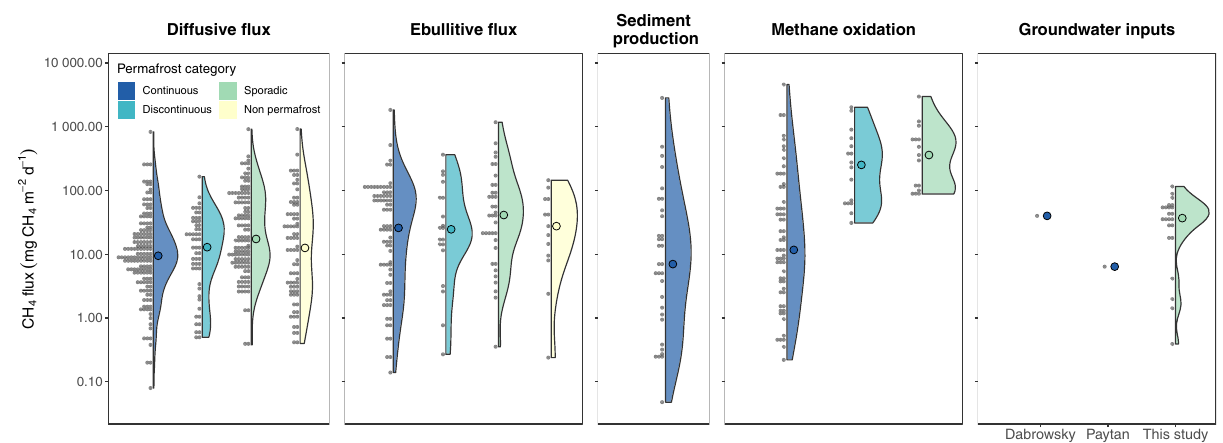
Fig. 4 Comparison of groundwater CH 4 inputs with other CH 4 fl uxes in Arctic lakes. Atmospheric fl uxes (diffusion and ebullition) were extracted from the Boreal-Arctic Wetland and Lake Methane Dataset (BAWLD-CH4) 20 . Sediment production 21 – 23 and oxidation 9,21,23 rates were obtained from incubation experiments found in the literature (see Supplementary